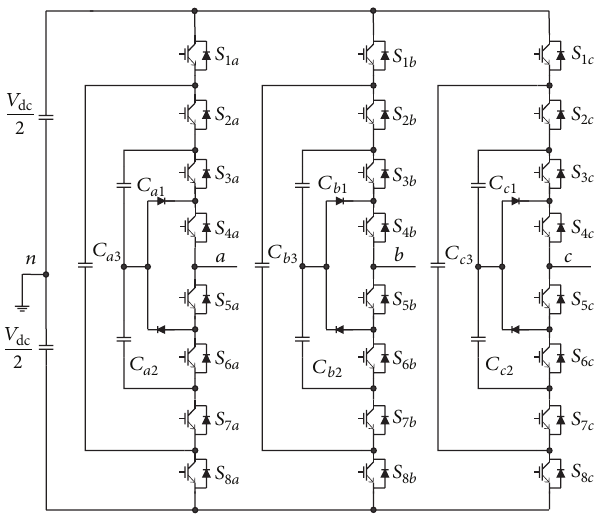
Figure 1: Schematic of the novel five-level inverter.